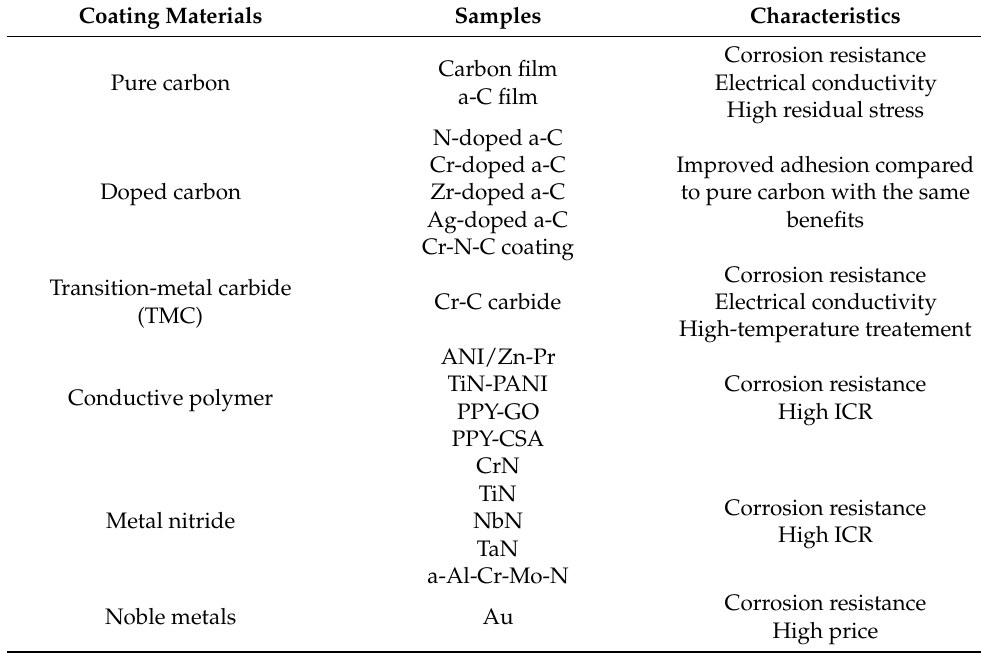
Table 3. Coating materials and their characteristics for protective coating of metallic BPs in PEMFCs.